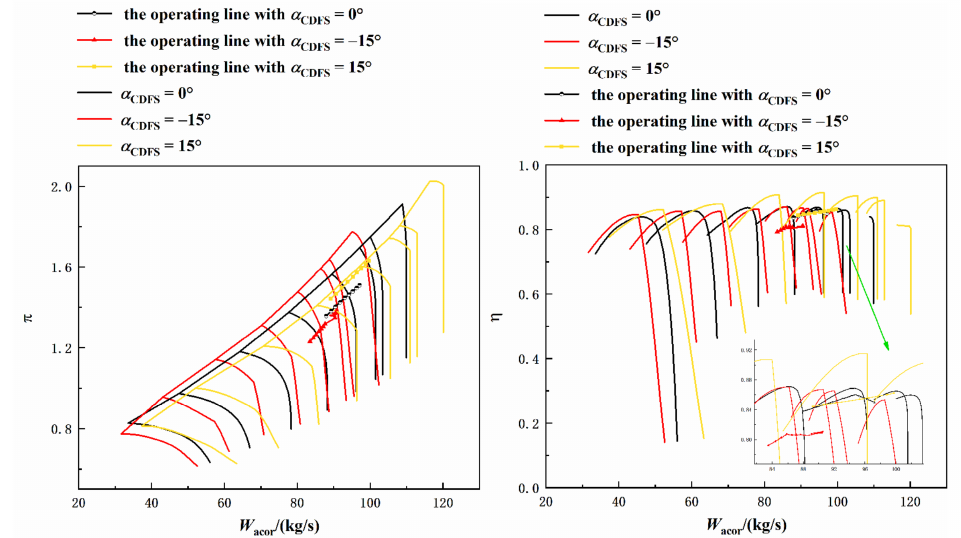
Figure 12. Variation diagram of engine operating points when the guide vane angle of CDFS changes.